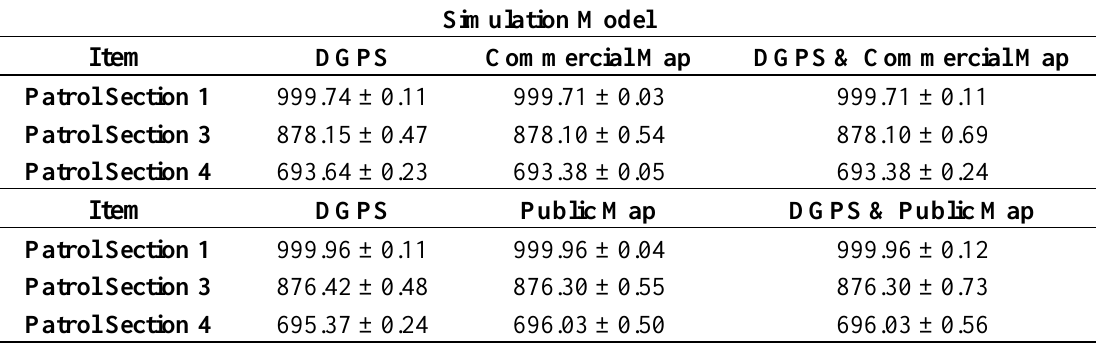
Table 5. The second sensitivity analysis: “Quantity of salt used for all events and each patrol section